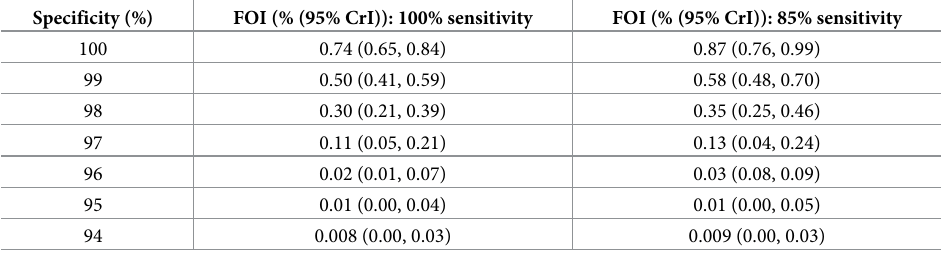
Table 1. Effect of variation in diagnostic specificity on the estimate of average annual force of infection (FOI) of Rift Valley fever virus infection in Tanzanian cattle, goats, and sheep between 2009 and